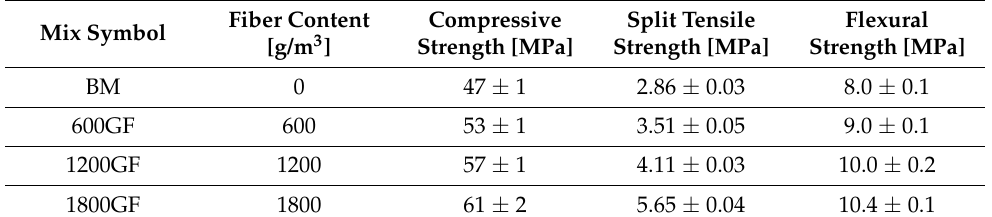
Table 7. Strength parameters of tested samples.